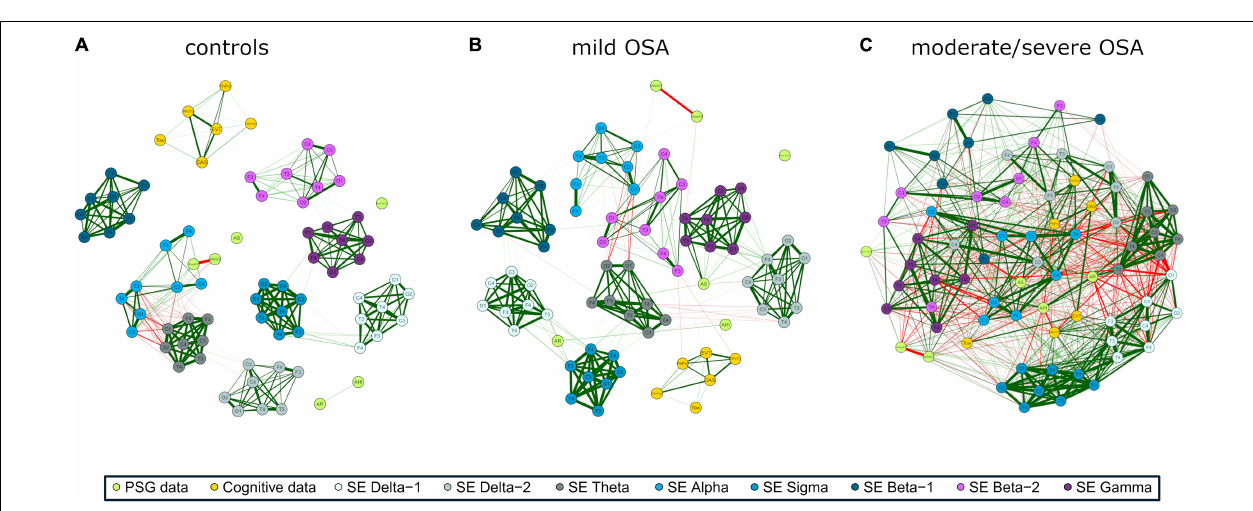
FIGURE 3 | EEG irregularity ( SpecEn ) correlation networks with PSG variables (AHI, AE, AR, NadirSpO2, WASO, and SleepEff) and cognitive scores (DAS, PPVT3, EVT, DesCop, PhPro, and Tow) for (A) controls, (B) mild OSA, and (C) moderate/severe OSA. Explanations regarding the construction of the networks are analogous to those from Figure 2